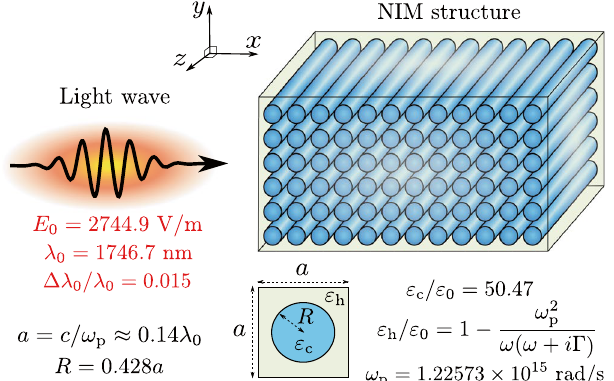
Figure 3. Schematic illustration of light incident to an inhomogeneous NIM block. The NIM structure consists of dielectric cylinders embedded in a plasmonic host material. Light is incident from the left and it propagates through the structure with minimal backward